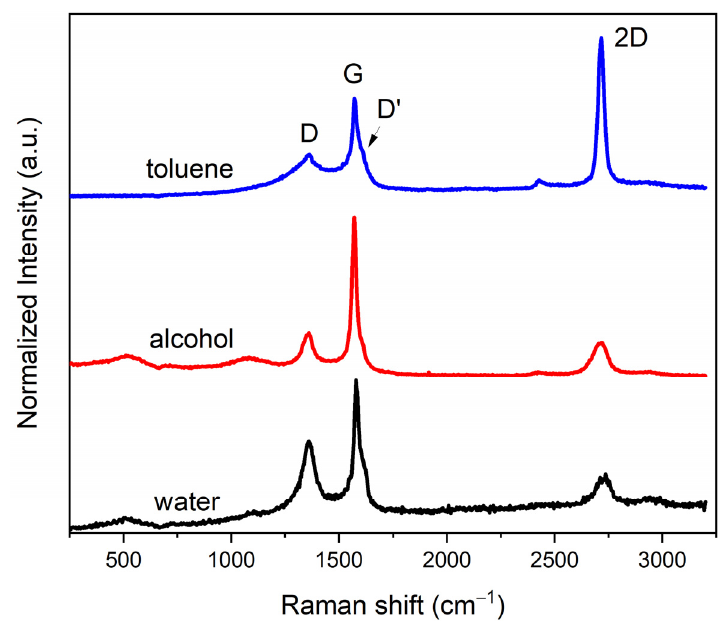
Figure 3. Raman spectra of nanoparticles obtained in three different liquids (water, alcohol, and toluene).